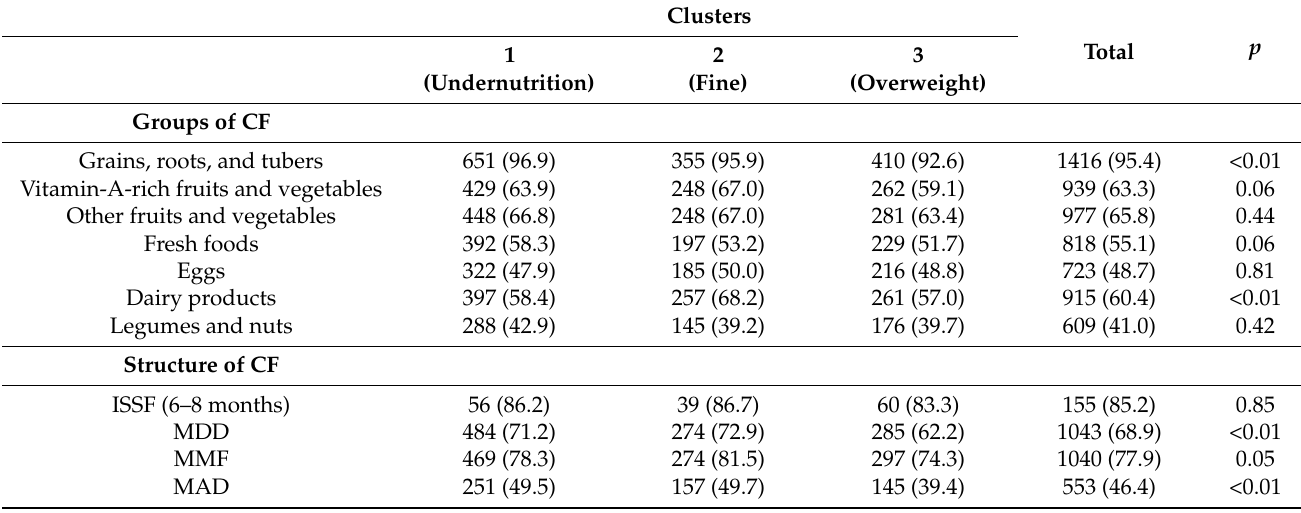
Table 4. The CF status in IYC with different z-scores.